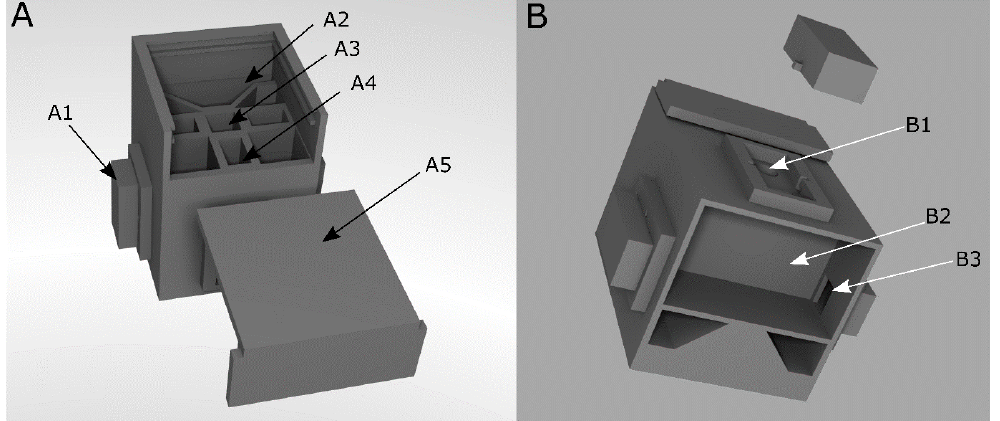
Figure 1. CAD model of the measurement chamber of the portable analysis system. ( A ): Front view. ( B ): Bottom view. A1: Lid to cover inserted LEDs and phototransistor, A2: Socket for SMD-LED board. A3: Place for a 10 mm-cuvette, A4: light path from LED to phototransistor, A5: Cover for the measuring chamber, B1: Place for LED or phototransistor B2: Bottom compartment for storage of a microcontroller and the circuit board, and B3: Path for cables to connect inserted LED and phototransistor